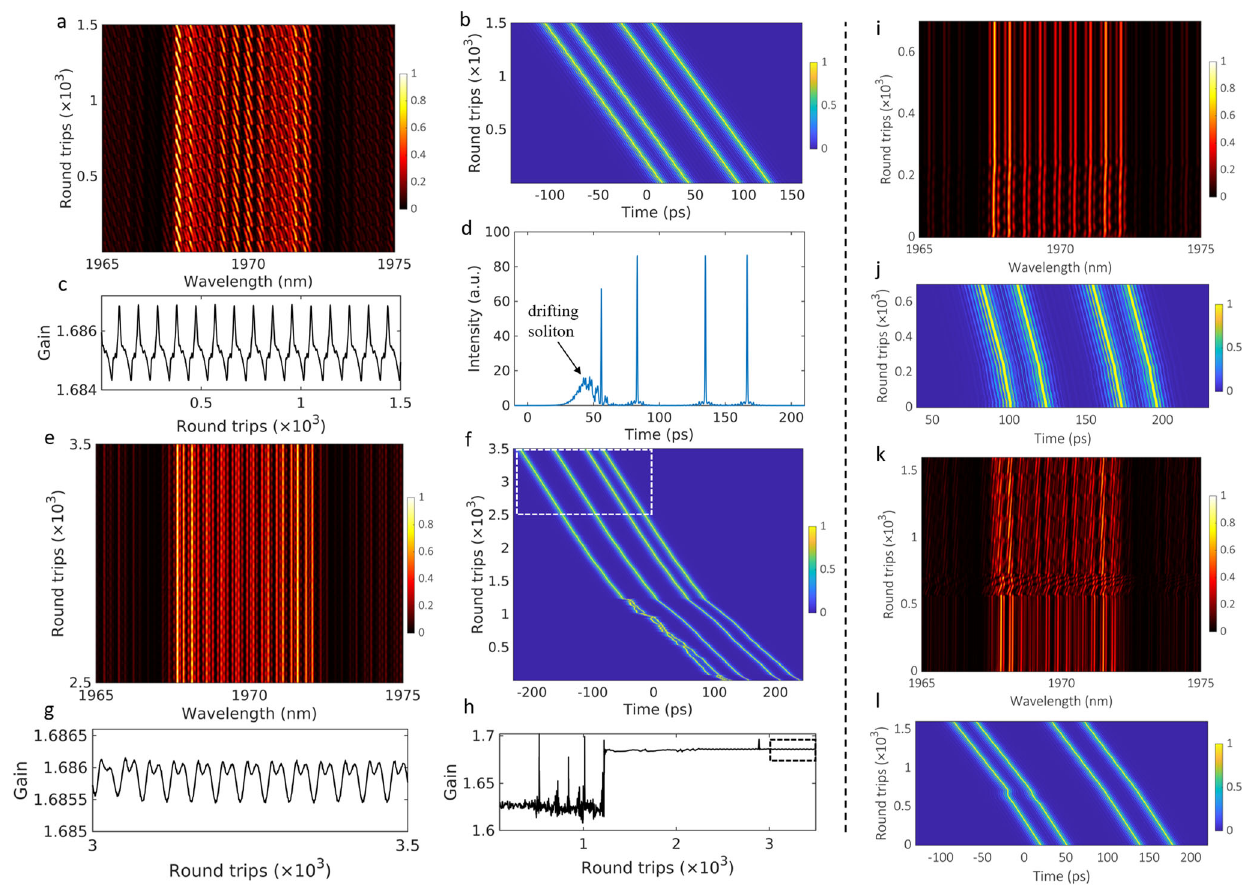
Fig. 7 Simulations of soliton molecular complexes switching. a – h Simulation of SMC switching with drifting soliton collision. Evolution of a spectrum and b temporal intensity of soliton molecules before switching. c The variation of average net gain coef fi cient in the range between 1960 to 1980 nm with the number of cavity roundtrips. d Temporal intensity of soliton molecule with drifting soliton collision. Evolution of e spectrum and f temporal intensity of soliton molecules after switching. g , h The variation of average net gain coef fi cient in the range between 1960 to 1980 nm with the number of cavity roundtrips after switching. i – l Simulation of SMC switching with variation saturable absorber parameters. Evolutions of the spectrum and temporal intensity of soliton molecules in ( i , j ) switching from oscillating phase to stationary state, ( k , l ) switching from stationary to sliding phase distribution [Fig. 2k] indicated that the temporal interval of the leading soliton-pair molecule does not change during switching. Meanwhile, the fi rst soliton in the trailing soliton-pair molecule is repulsive, and the second and third soliton attraction compares to the leading soliton-pair molecule, indicating a more complex binding potential variation during switching (from RT 245 to RT 310). These observations in soliton quartet and quintet molecule, and (2 + 3) OSMC further demonstrate that self-sustained switching is a common dynamical attractor in the 2- μ m fi ber laser that the different soliton assembles forms suggest similar periodic switching behavior 47,48 .